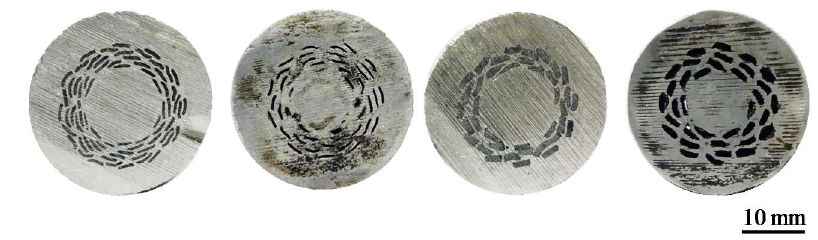
Figure 2. Cross-sections of the fabricated specimens. Table 2. Properties of the recovered specimens.